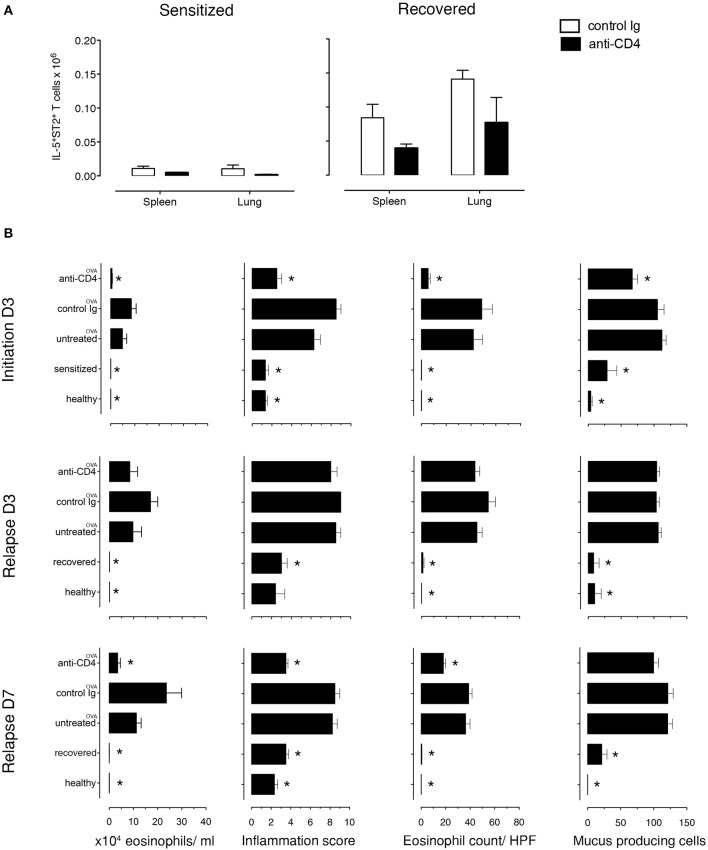
Lung allergen-specific Th2 cells remaining after anti-CD4 mAb depletion mediate early inflammatory response to allergen rechallenge. Sensitized and recovered mice were treated i.p. with 0.2 mg of anti-CD4 depleting mAb (clone GK1.5; anti-CD4) or isotype control antibody (control Ig) for 3 consecutive days. Three days after the last treatment, single lung and spleen cell suspensions were prepared for FACS analysis for one cohort of mice and a second cohort of mice was challenged with 100 μg of OVA i.n. to induce allergic asthma in sensitized mice (untreated OVA, control Ig OVA, anti-CD4 OVA) or disease relapse in recovered mice (untreated OVA, control Ig OVA, anti-CD4 OVA). Disease parameters were evaluated at D3 and D7 after allergen challenge. (A) Lung and spleen cells from sensitized or recovered mice (n = 6–8) treated with control Ig or anti-CD4 mAb were stimulated for 9 h with OVA-loaded peritoneal macrophages. Bar graphs indicate IL-5+ST2+ T cell numbers presented as mean ± SEM from two independent experiments. (B) Absolute eosinophil numbers in BAL grade of inflammation in H&E-stained lung sections, eosinophil numbers on LUNA-stained lung sections, and the number of mucus-containing cells in central airways on PAS-stained lung sections during initiation, at D3 and D7. Data are presented as mean ± SEM from two independent experiments (n = 6–8). *p < 0.05 is statistically significant compared with the untreated group.